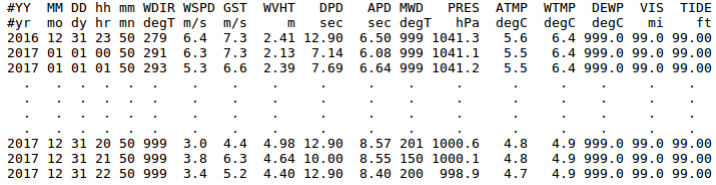
Figure 1. A fragment of an annual text file of the Station 46001